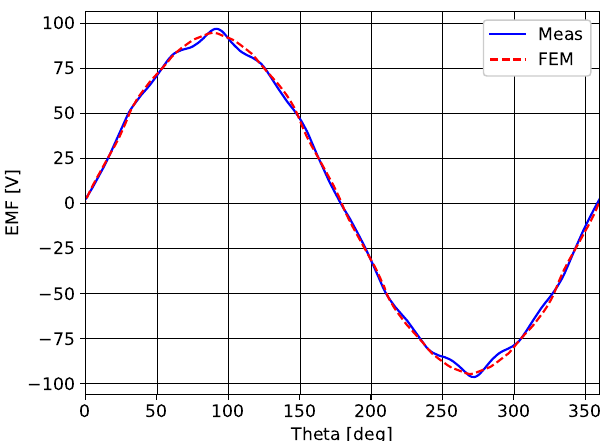
Figure 13. No-load back-EMF at 1016 rpm measured and simulated line-line voltage in